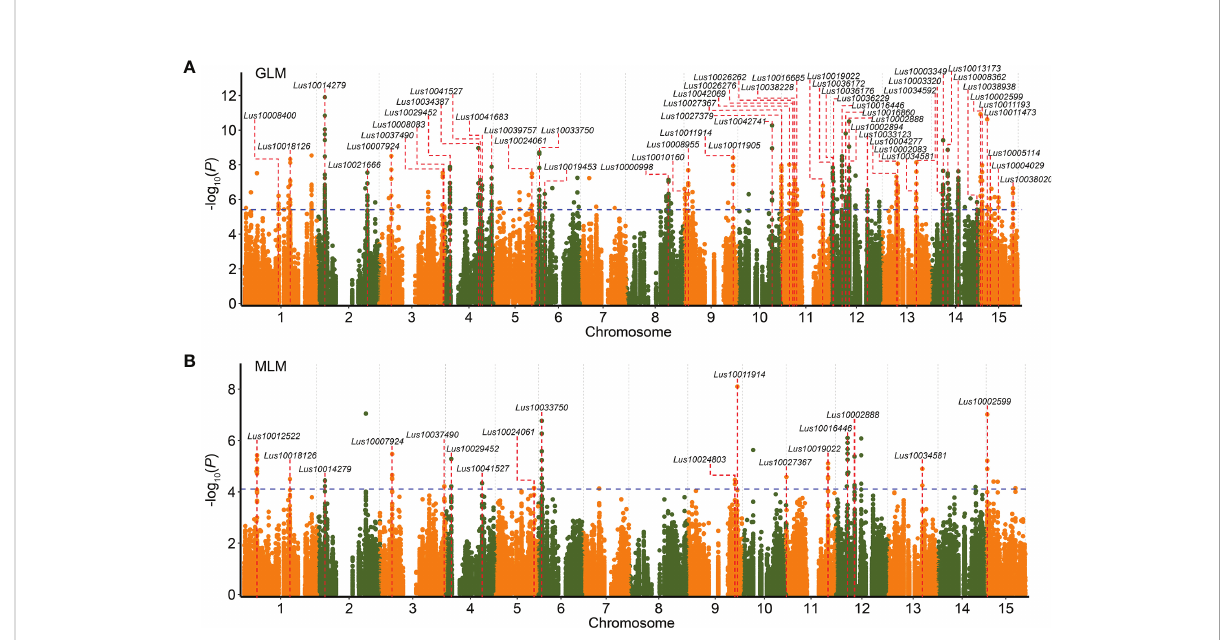
FIGURE 4 Differentially expressed gene (DEG) – based association study for seed size and weight. (A, B) The overlapping Manhattan plots for seed length, seed width, and 1,000-seed weight in four environments (including 2016DL, 2017UR, 2019UR, and 2019YL) using general linear model (GLM) (A) and mixed linear model (MLM) (B) . Blue dashed lines represent signi fi cance thresholds ( − log 10 ( P ) = 5.41 in A ; − log 10 ( P ) = 4.11 in B ). Red dashed lines indicate DEGs that were repeatedly detected in at least two environments related to seed size and